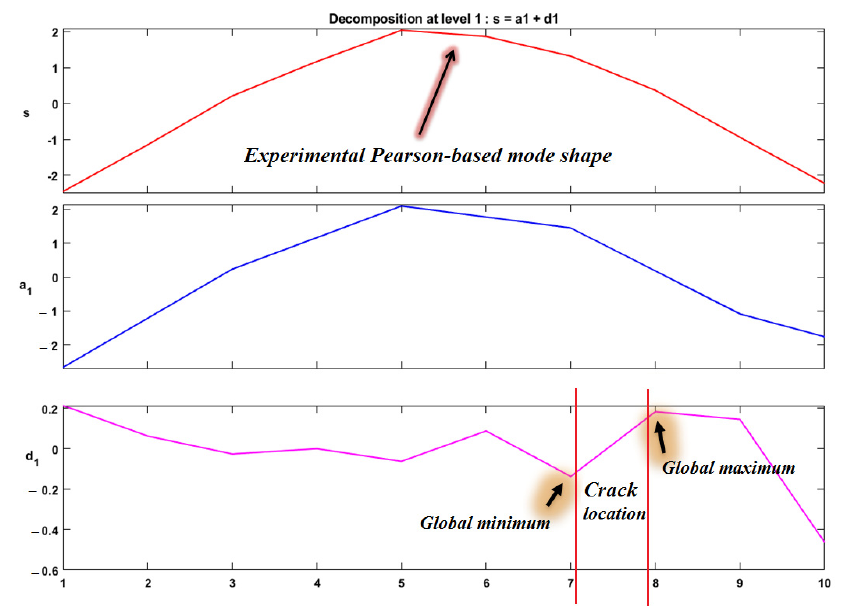
Figure 20. Damage detection by 1D-DWT from the Pearson-based coefficient extracted from experimental intact and damaged mode shapes.